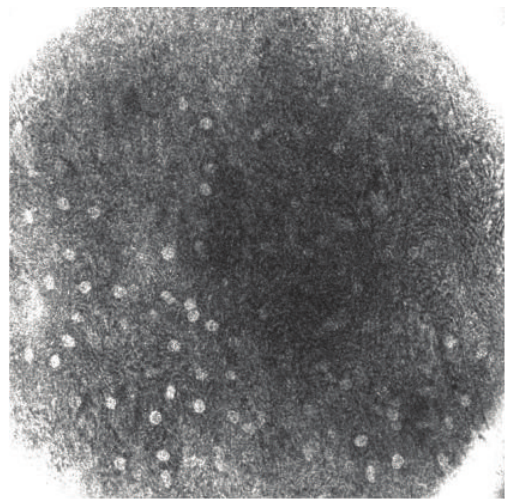
Figure 2: Reflectance confocal microscopy image at Z0 showing ill- demarcated cells with bright nuclei surrounded by a dark halo.